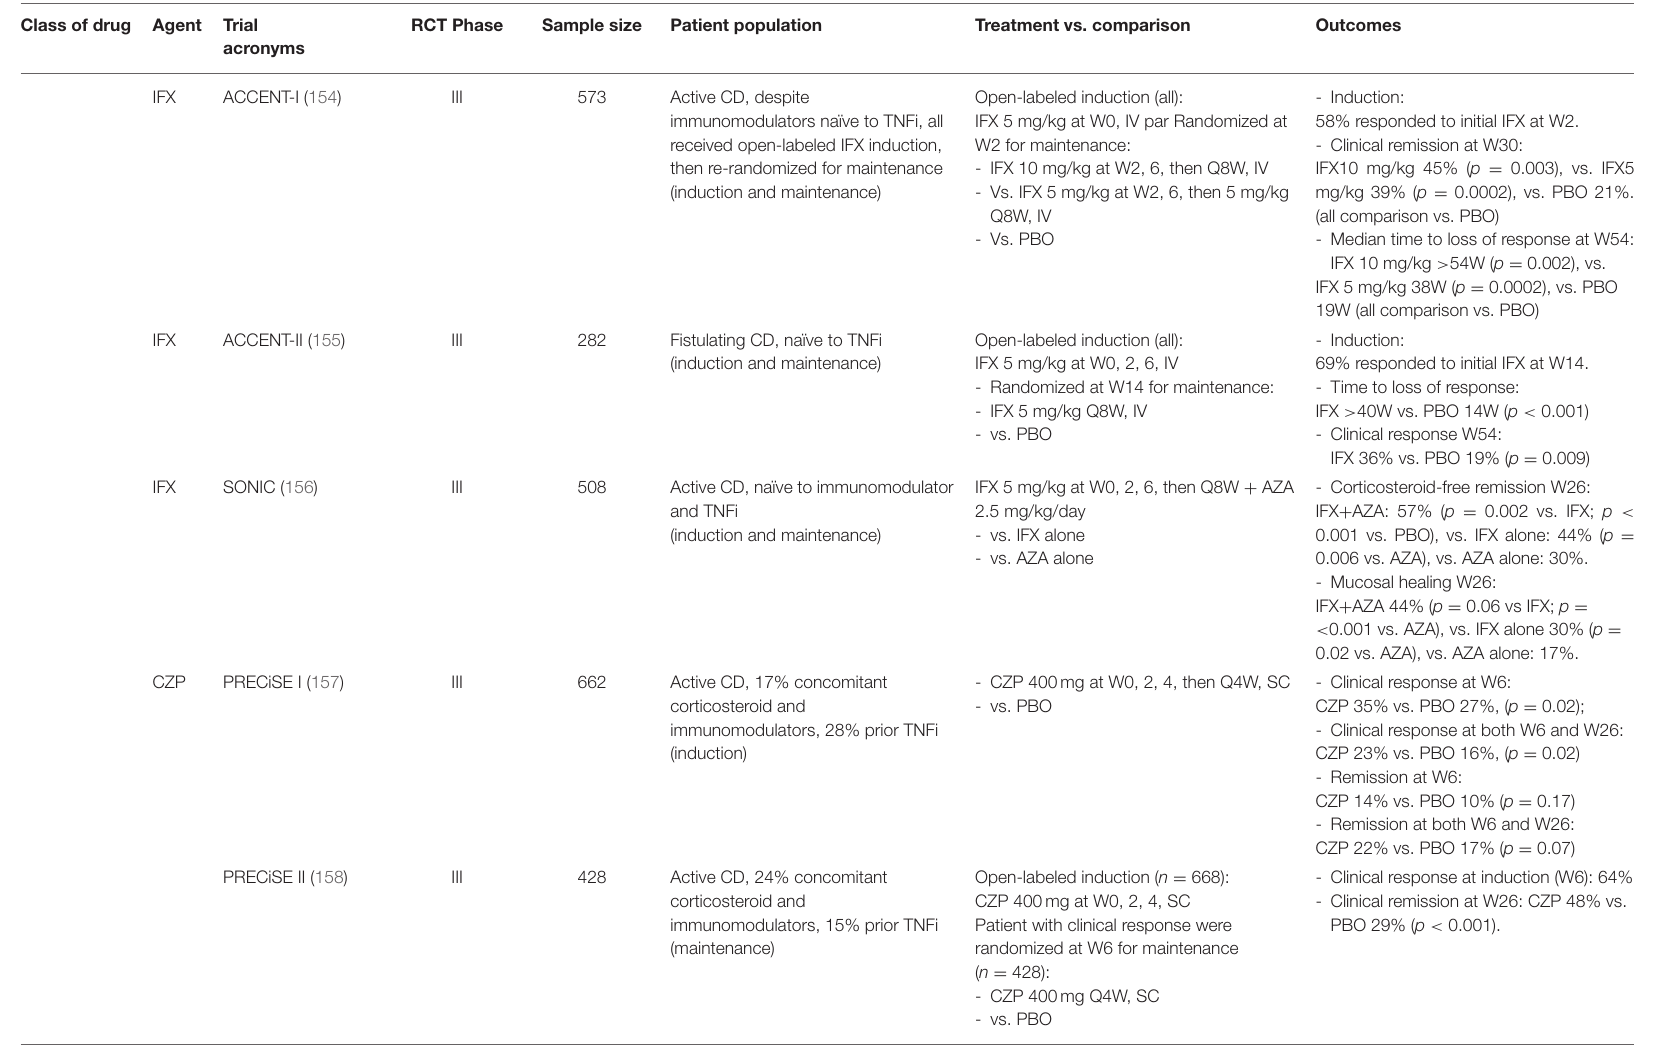
Class of drug Agent Trial